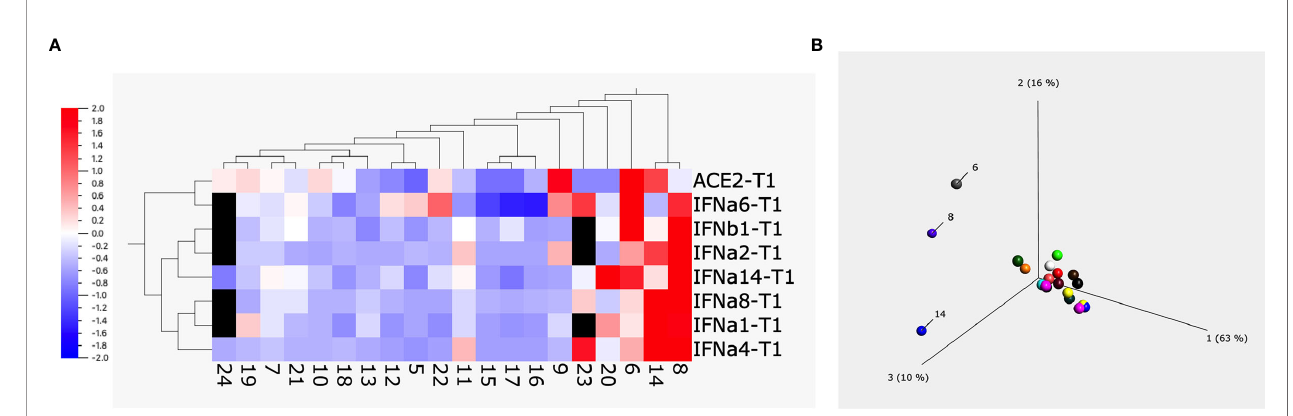
FIGURE 2 | The heatmap and principal component analysis (PCA) plot of ACE2 and type I interferons after spike protein treatment. Heatmap (A) and PCA plot (B) were built up using the data obtained from BAL fl uids of 20 naïve macaques treated with 1µg/ml of spike protein S1 for 20 hrs using Qlucore Omics Explorer software. The missing data (due to the low copy number of some genes) was fi lled with black squares. The scale in (A) is the relative expression level of the genes. The numbers below the heatmap, and in the PCA plot are the animal IDs.